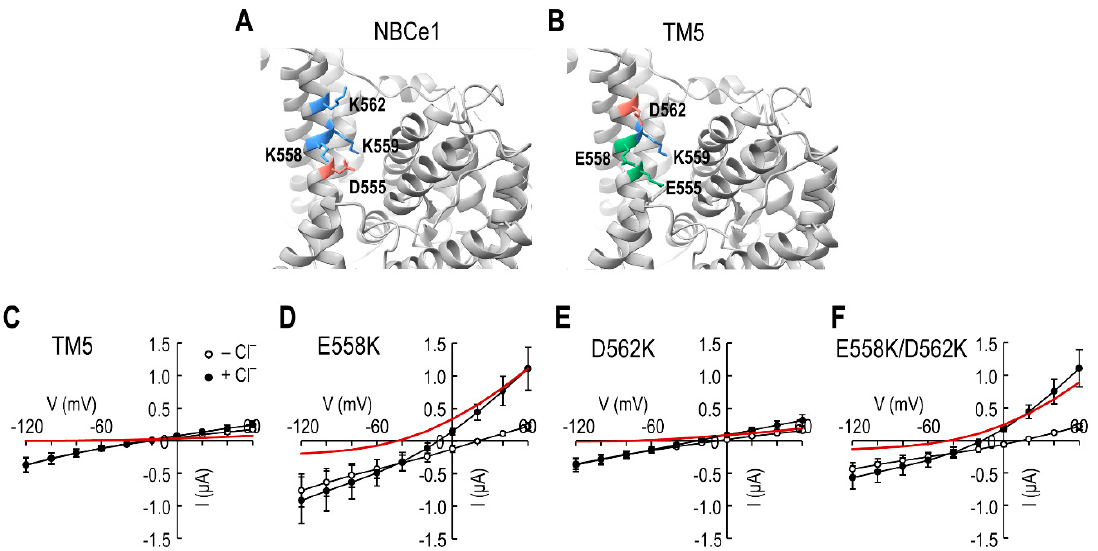
Figure 4. Lys 558 replacement in the TM5 chimeric transporter induces I Cl . ( A ) Anion binding site S2 in NBCe1. Site S2 is constituted with Asp 555 , Lys 558 , Lys 559 , and Lys 562 . ( B ) Amino acid residues at the corresponding positions in the TM5 chimeric transporter. Glu 555 , Glu 558 , Lys 559 , and Asp 562 are present at the site equivalent to S2. ( C – F ) I–V relationships of point mutant transporters for I Cl . E558K, D562K, and E558K/D562K are point mutants constructed on the chimeric transporter. The difference between the two mean is I Cl (red line). Data were averaged from 4–5 oocytes per group.